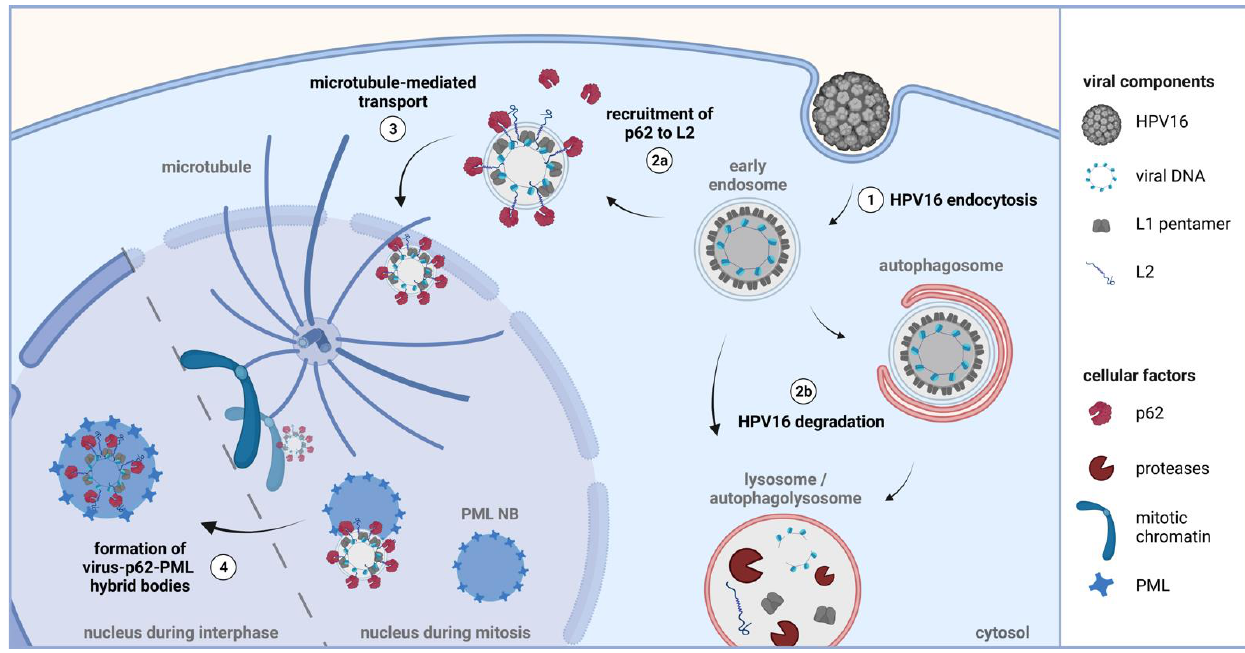
Figure 6. Model of p62 nuclear translocation and formation of virus-p62-PML hybrid bodies during HPV16 entry. ( 1 ) HPV16 enters its host cell via endocytosis. Maturation of the virus-filled early endosome enables L2 insertion into the endosomal membrane and allows for L2 interaction with cytoplasmic p62 ( 2a ). This interaction protects the virus from autophagosomal and/or lysosomal degradation by proteases ( 2b ). With the onset of mitosis, associations with microtubules and mitotic chromatin facilitate further transportation of the of virus-filled vesicles into the newly formed nucleus ( 3 ). Here, HPV16-p62 complexes fuse with re-assembling PML NBs and form virus-associated p62-PML hybrid bodies ( 4 ), enabling immune evasion and viral gene transcription. Created with BioRender.com (accessed on 31 May 2022).